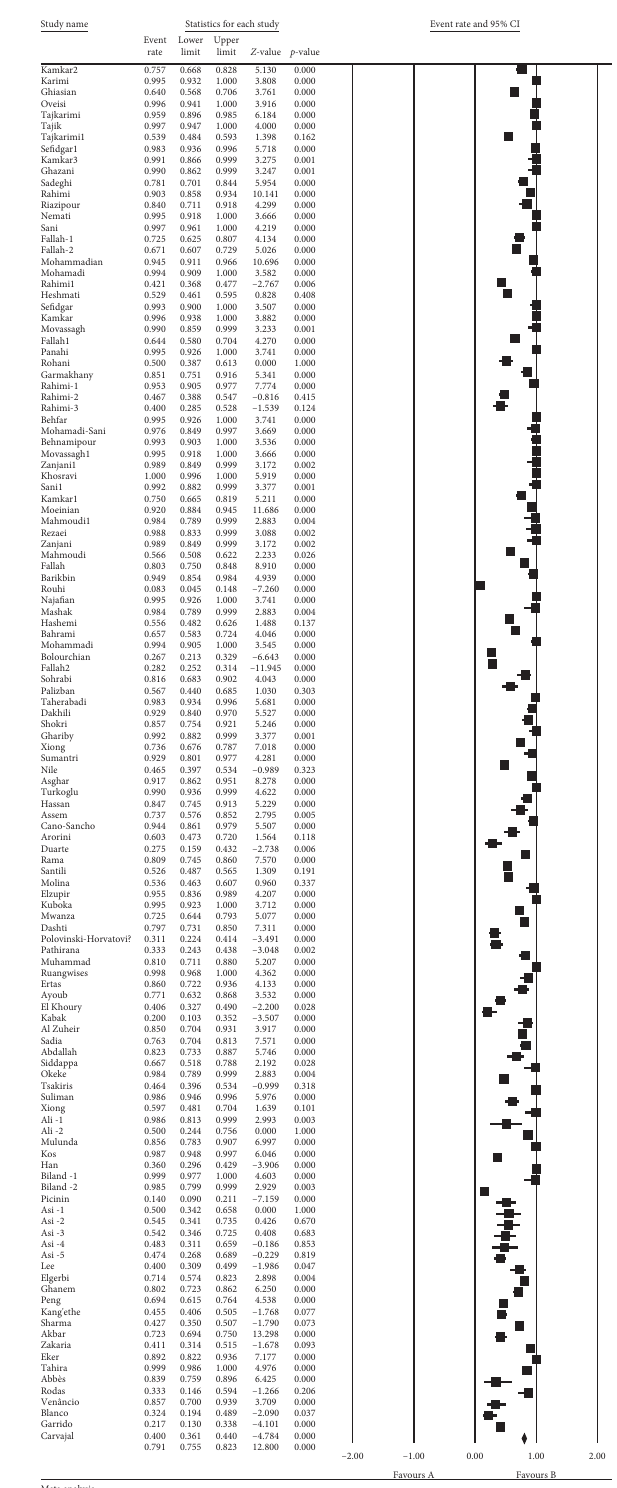
Figure 3: Prevalence of aflatoxin M1 in milk worldwide and 95% confidence